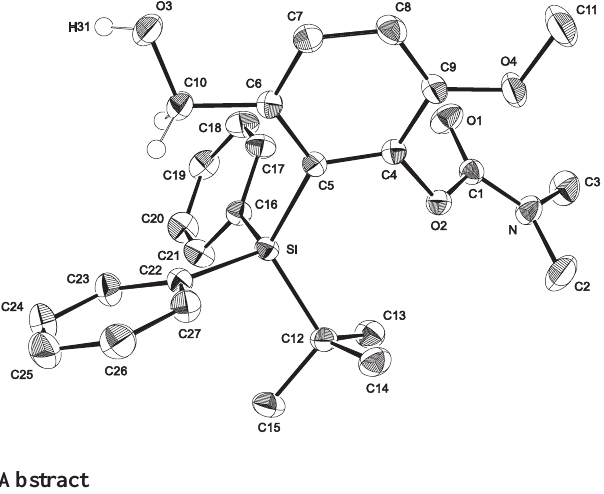
Table 1. Data collection and handling.